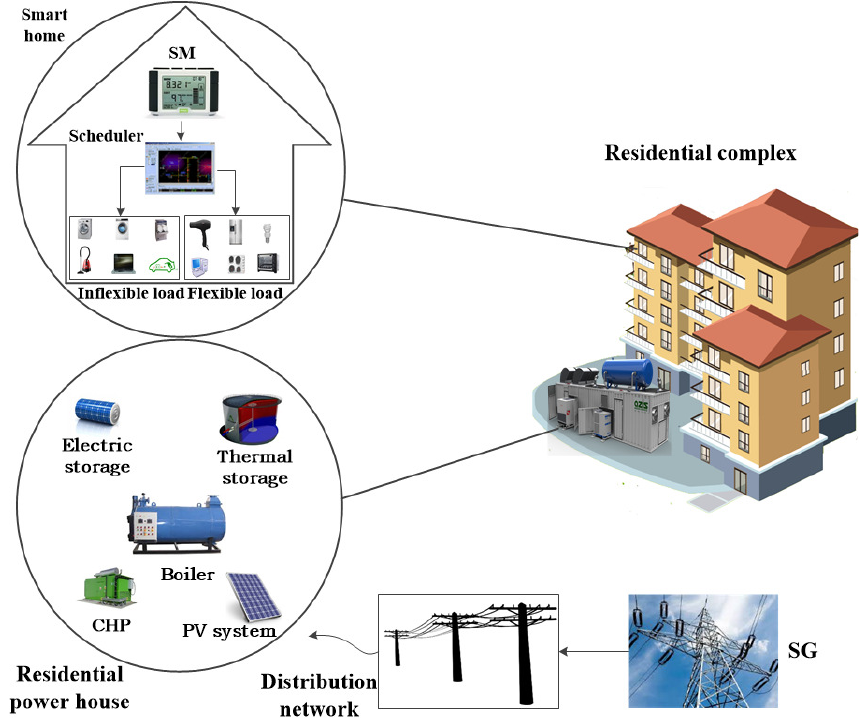
Figure 2. Smart residential